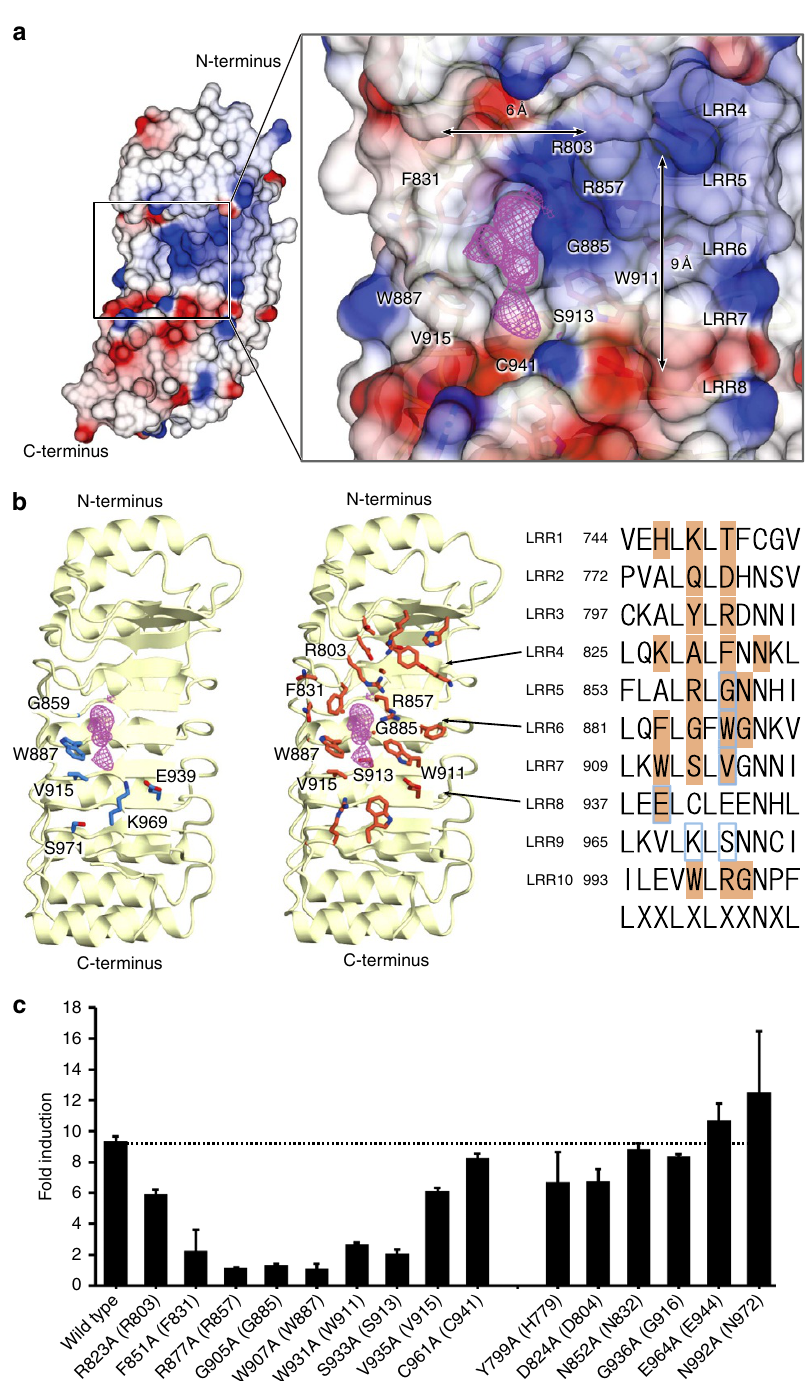
Figure 3 | Potential ligand-binding site on the concave surface of LRR. ( a ) Semi-transparent surface representation showing the concave face of the LRR domain. The potential ligand-binding site is indicated by a rectangle (left) and is magnified on the right side of the panel. The residues forming the pocket are shown as stick structures and labelled. Positive and negative electrostatic potentials are shown in blue and red, respectively. The F o (cid:3) F c difference electron density in the pocket is contoured at the 3.0 sigma level with magenta mesh. ( b ) The residues in the ligand binding implicated by mutational study 27 (left) and sequence conservation analysis (middle) are shown as blue and coral stick structures, respectively. The residues conserved among all species of NOD2 (listed in Supplementary Fig. 1) are shown in the middle panel, except for those at positions 1, 4, 6, 9 and 11, of the first 11 residues of each LRR (shown in the right panel). The residues shown in the left and middle panels are highlighted in the right panel in blue and coral, respectively. ( c ) MDP induced NF- k B activation of the human NOD2 mutants for the residues forming the proposed MDP-binding pocket and its peripheral region. Residues in parenthesis are derived from rabbit NOD2. Luciferase activity was measured by NF- k B-dependent luciferase reporter assay using HEK293T cells co-expressing rabbit NOD2 and human SLC15A3. Data represent the mean fold induction of NF- k B activity ( n ¼ 3, ± s.d.), calculated as the relative light units (RLU) of cells stimulated with MDP divided by the RLU of non-stimulated cells. Dotted lines indicate activity of wild-type